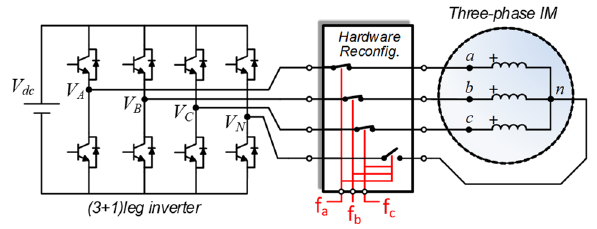
Figure 1. Fault-tolerant AC drive with (3 + 1) leg inverter and switches to emulate the open phase fault and reconfiguration. The signals fa, fb, and fc are designed to emulate OPF on phase a, b, or c.